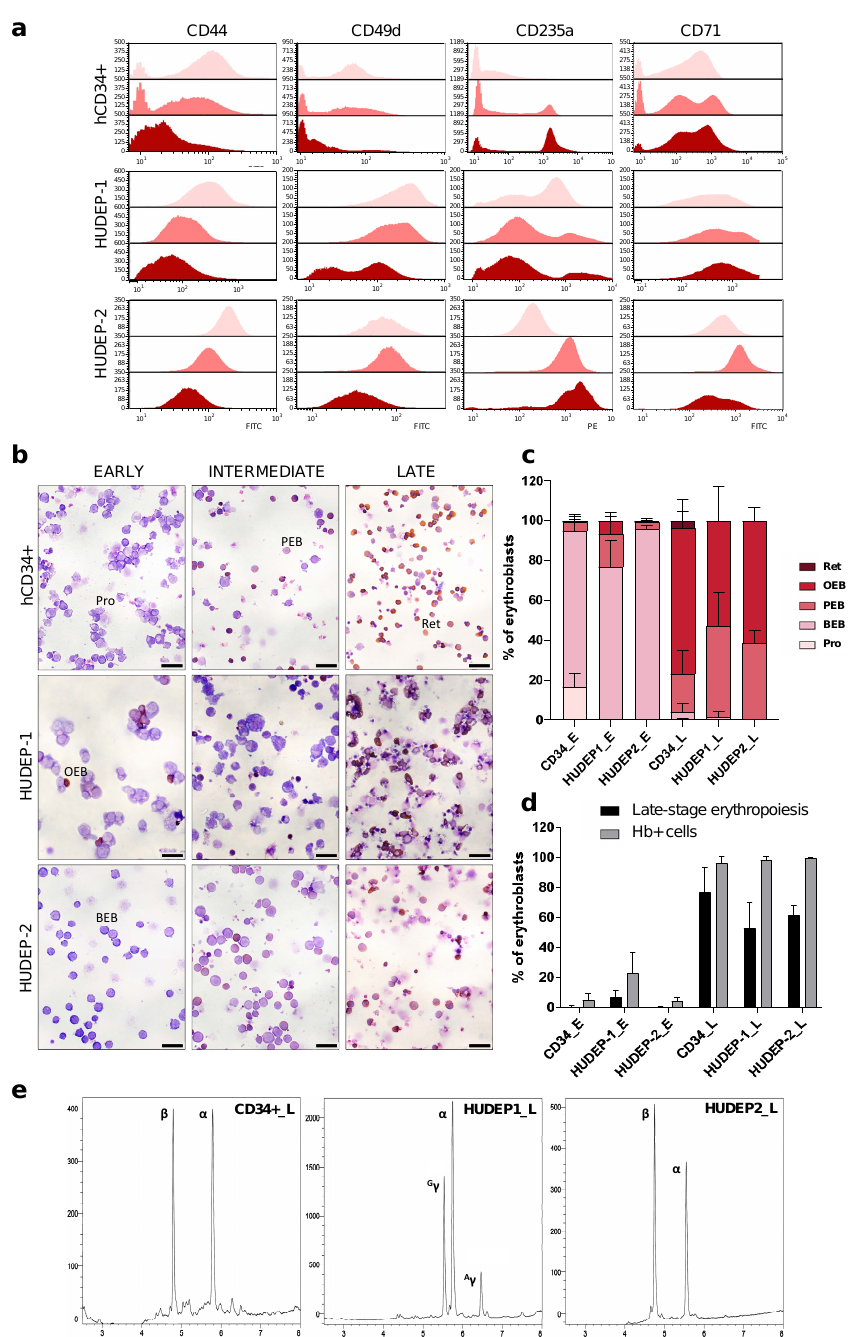
Figure 2. Assessment of erythroid differentiation in cell culture systems. ( a ) Flow cytometric analysis of indicated surface markers (CD44, CD49d, CD235a, and CD71) during erythroid differentiation. Colors in stacked overlaid histograms represent the three stages of erythroid differentiation: _E (pink), _I (light red), and _L (dark red). The ordinate represents the number of cells displaying the